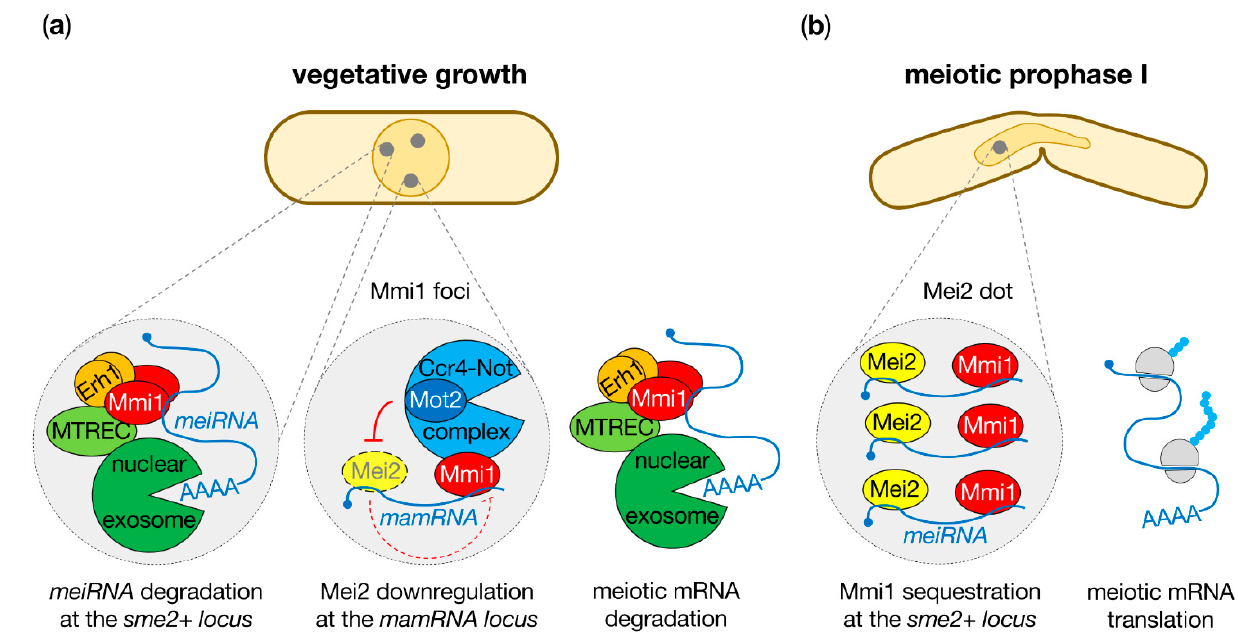
Figure 2. The lncRNAs meiRNA and mamRNA modulate the activities of the RNA-binding proteins Mmi1 and Mei2 to tune meiotic gene expression. ( a ) During vegetative growth, Mmi1 targets DSR-containing meiotic RNAs, including meiRNA , for degradation by the nuclear exosome. Mmi1 also associates with mamRNA to target Mei2 for ubiquitinylation and downregulation by the E3 ubiquitin ligase subunit Mot2 of the Ccr4-Not complex (see Section 4). Two of the scattered Mmi1 nuclear foci overlap with meiRNA and mamRNA transcription sites. The localization of the additional foci is not known. Whether meiotic mRNA degradation occurs within these structures also remains to be investigated. ( b ) During meiotic prophase I, Mmi1 is sequestered by Mei2 and meiRNA in the so-called Mei2 dot that lies at the meiRNA transcription site (i.e., sme2 + gene). This allows meiotic mRNAs to escape degradation and enter translation, thereby ensuring meiosis progression.